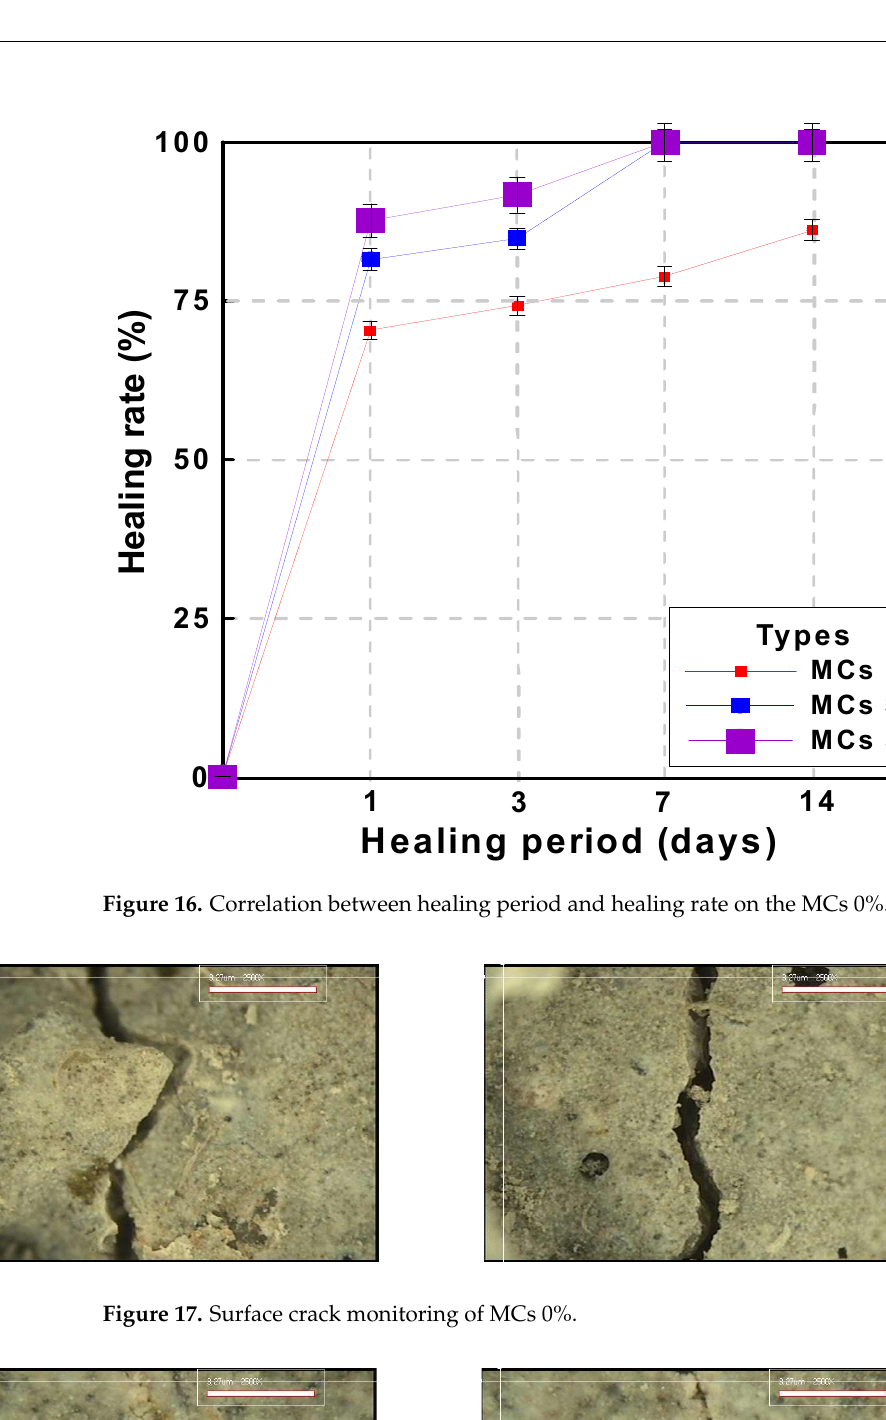
Figure 17. Surface crack monitoring of MCs 0%. Figure 18. Surface crack monitoring of MCs 1%.